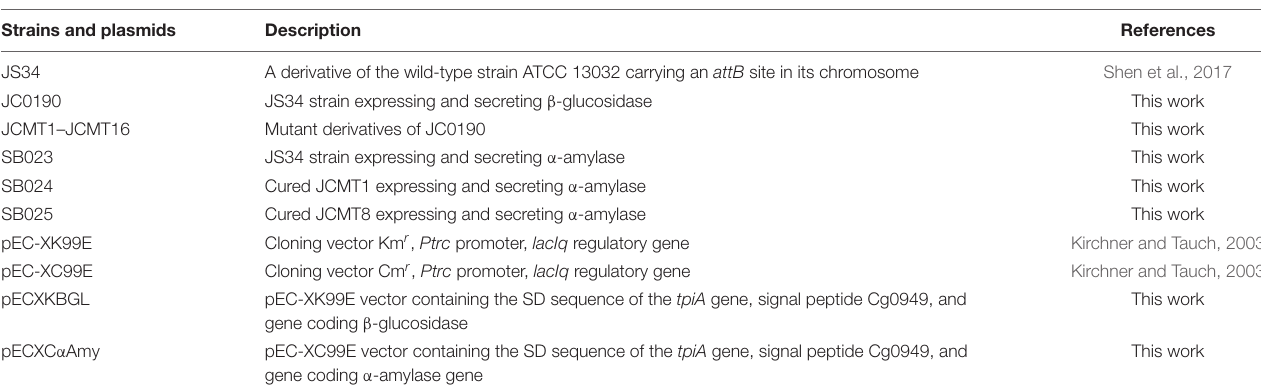
TABLE 1 | Summary of strains and plasmids